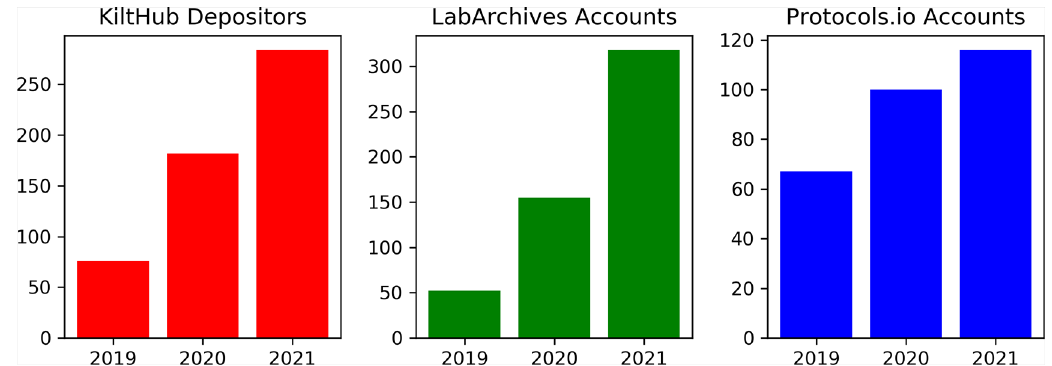
Figure 5. Tool usage over time (2019-2021). Number of total depositors on KiltHub, user accounts on LabArchives, anduseraccountsonprotocols.ioincreasedeachyearsincethebeginningoftheprogramin2018.Valuespresented are cumulative